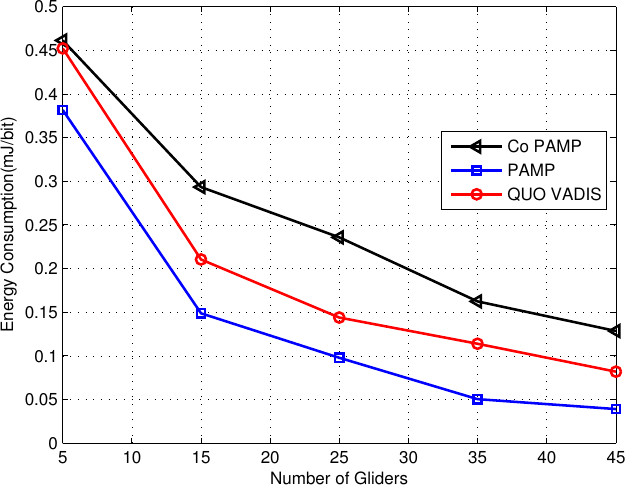
Figure 9. Energy consumption